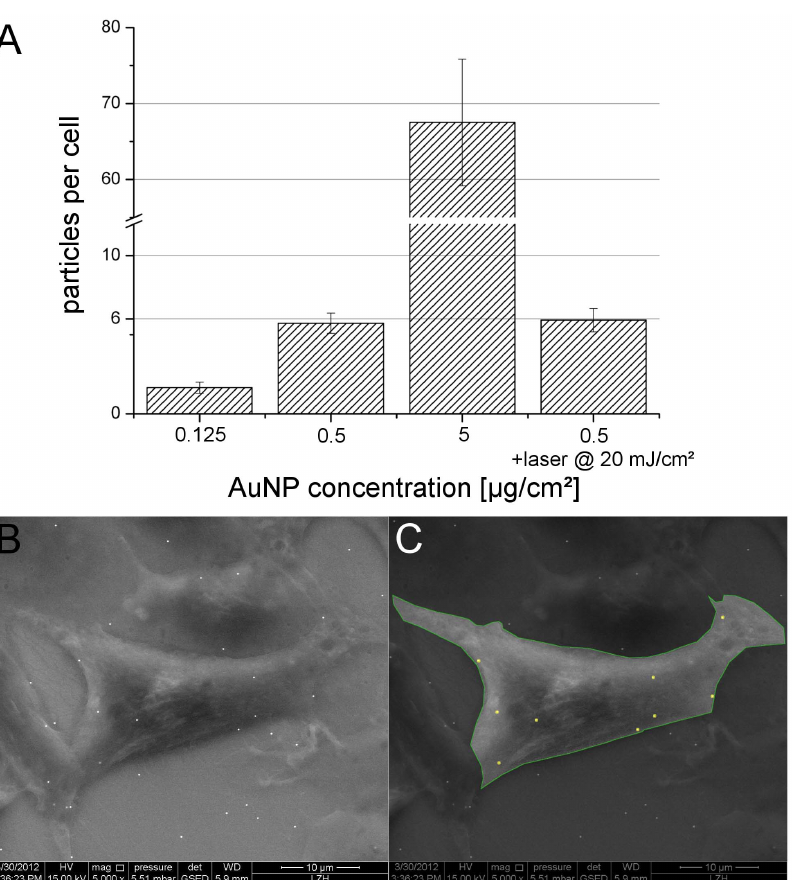
Figure 4. Number of particles per cell. A: Particle count per cell after 3 hours of incubation with different AuNP concentrations. No significant difference in the particle count was observed after irradiation with 20 mJ/cm 2 (p=0.46). Values represent the mean of n=3 experiments 6 SEM. B: ESEM image of one exemplary ZMTH3 cell incubated for 3 h with 0.5 m g/cm 2 200 nm AuNP in RMPI. C An individual cell was marked and the particles were counted.